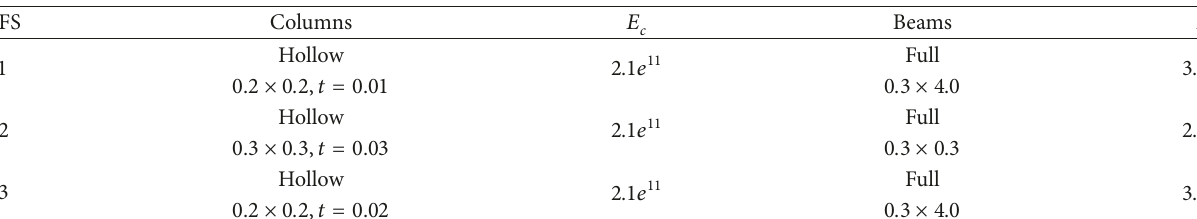
Table 1: Cross sections columns ([m]), cross sections beams ([m]), Young’s modulus of the columns ( 𝐸 𝑐 [N/m 2 ]), and Young’s modulus of the beams ( 𝐸 𝑏 [N/m 2 ]) of the frame system (FS).